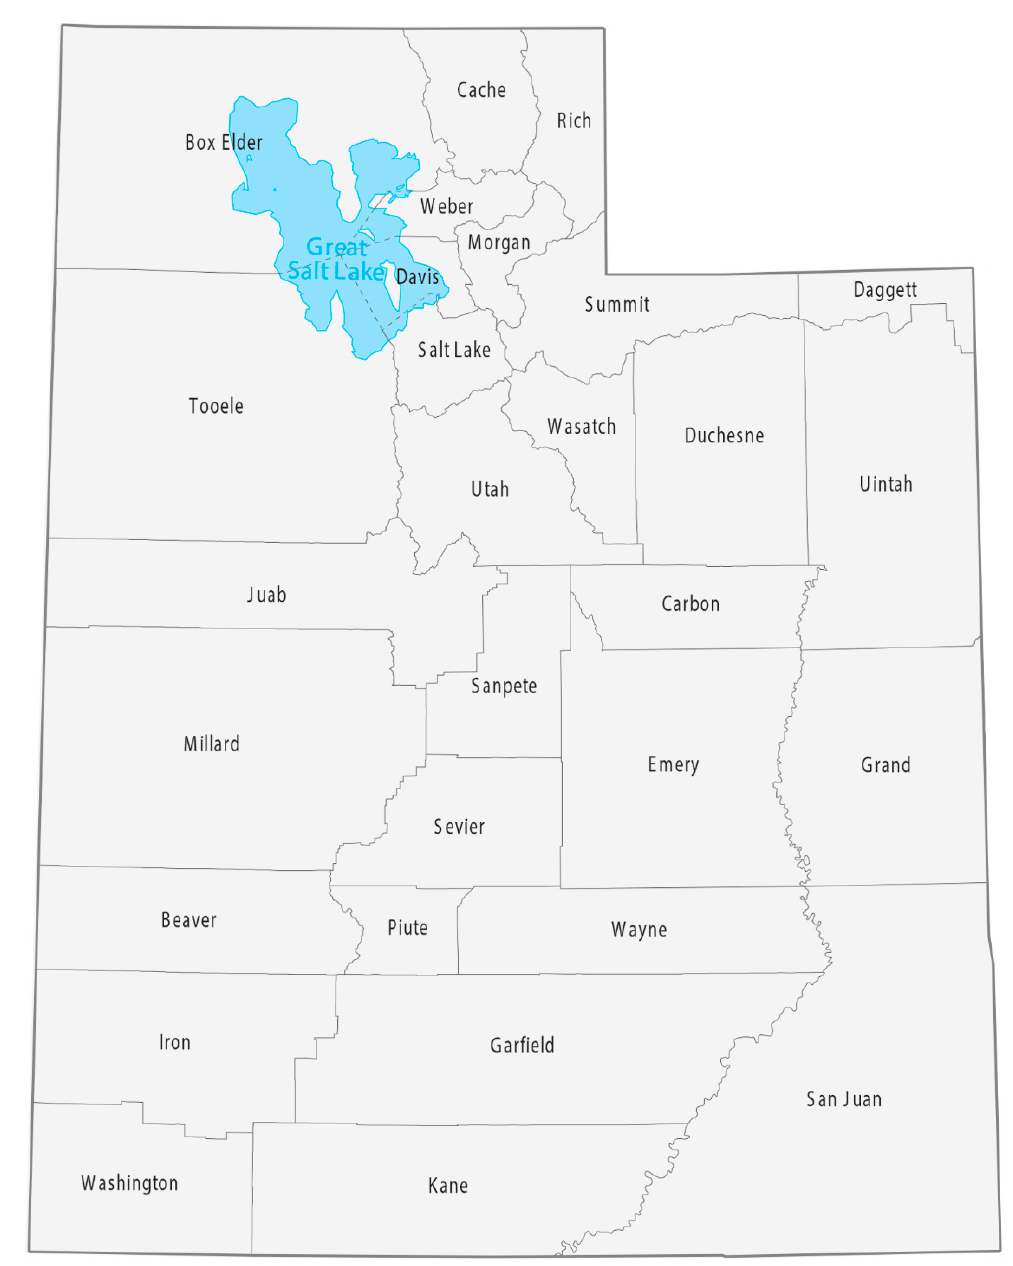
Figure 1. Map of Utah, including the Great Salt Lake (GSL) and names of counties.